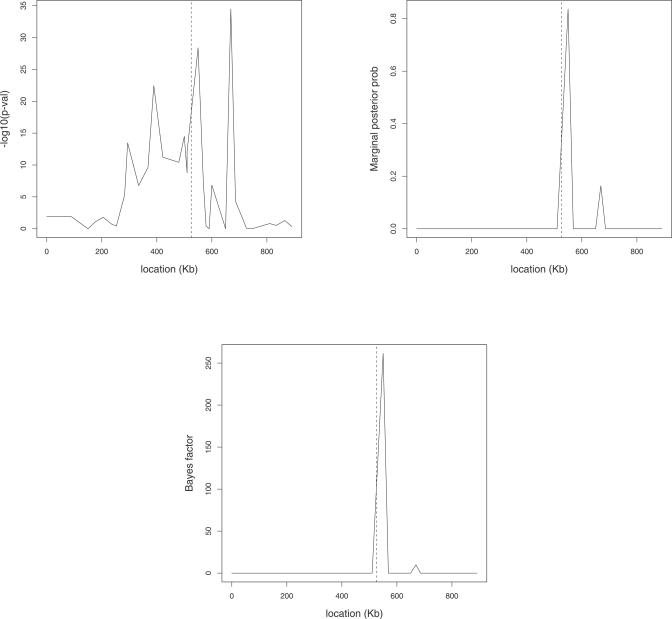
Results of Fisher's Exact Test and BETA Using the CYP2D6 Dataset
p-Values from Fisher's exact test for single marker-disease association (top left), the marginal posterior probability of association (top right) and the Bayes factor in favour of association at each marker (bottom centre) from the CYP2D6 gene region, where the vertical line on the x-axis indicates the location of CYP2D6.